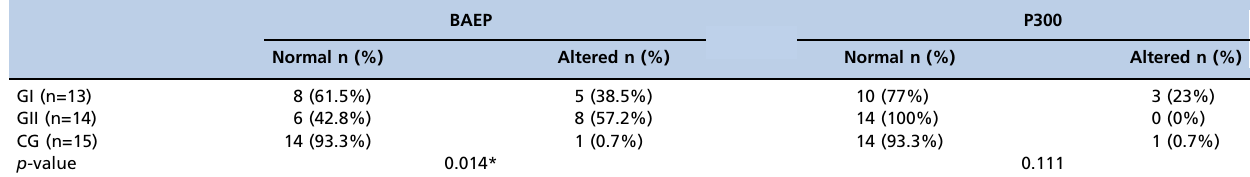
Table 5 - Distribution of electrophysiological assessment (BAEP, P300) results (normal or altered), by individual (number and